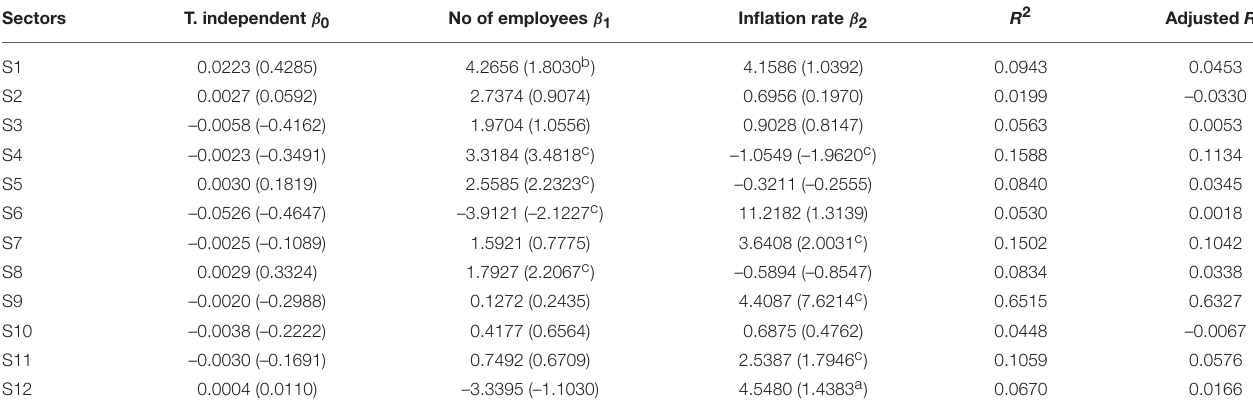
TABLE 3 | Estimation of FT coefficients with the variable “no of employees.”